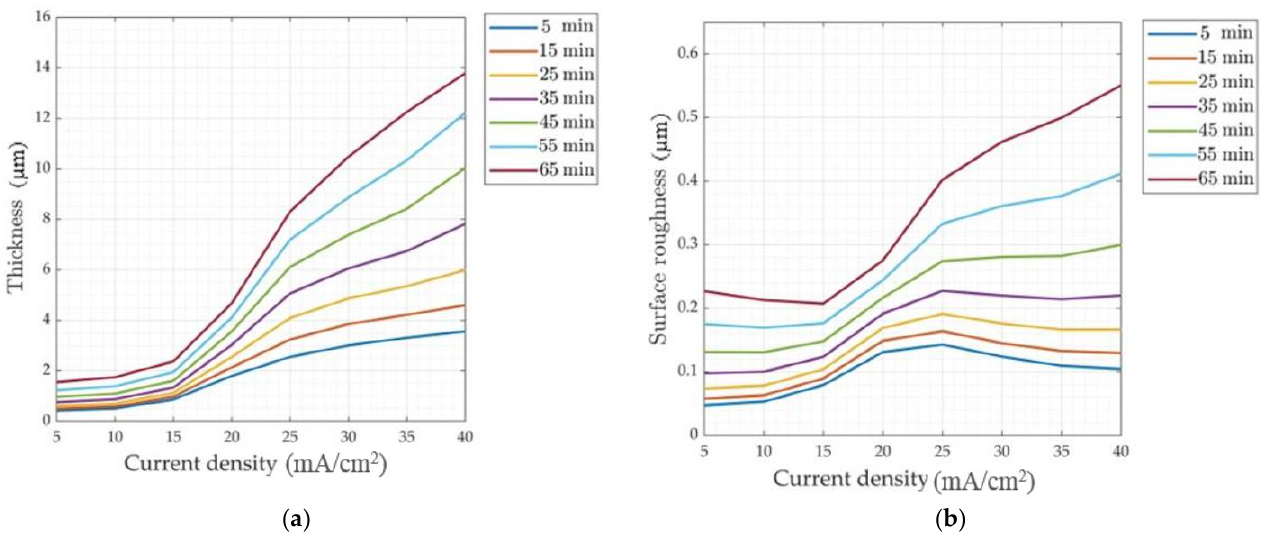
Figure 11. The results of the NN prediction on the effect of current density at RTD of 3, beam width of 50 μm , and stirring speed of 220 rpm, relative to ( a ) thickness of nickel coated layer; ( b ) surface roughness of nickel coated